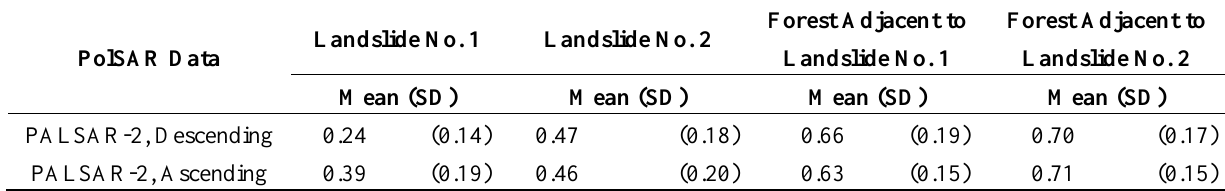
Table 3. Statistics of the normalized volume scattering power p v in landslides and those of neighboring forest.